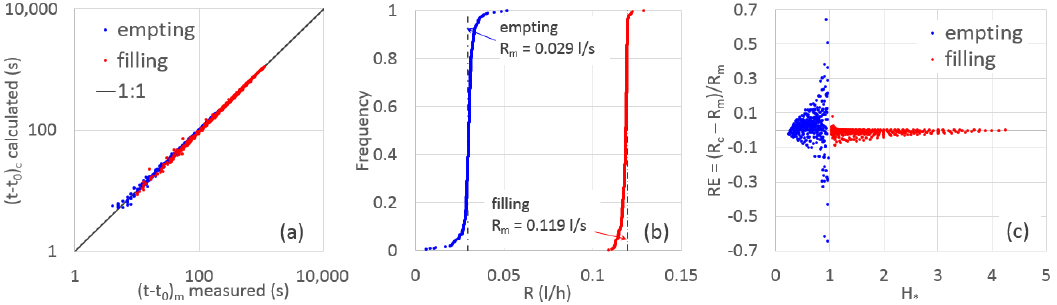
Figure 8. For the considered emptying ( R m = 0.029 l / s) and filling ( R m = 0.119 l / s) processes, (a) comparison between the time measured, ( t - t 0 ) m , with that calculated according to the suggested procedure ( t - t 0 ) c , (Equation (16)); (b) frequency distribution of the calculated input discharge, R c (Equation (29)); and (c) relative error, RE , versus the normalized water level, H * .